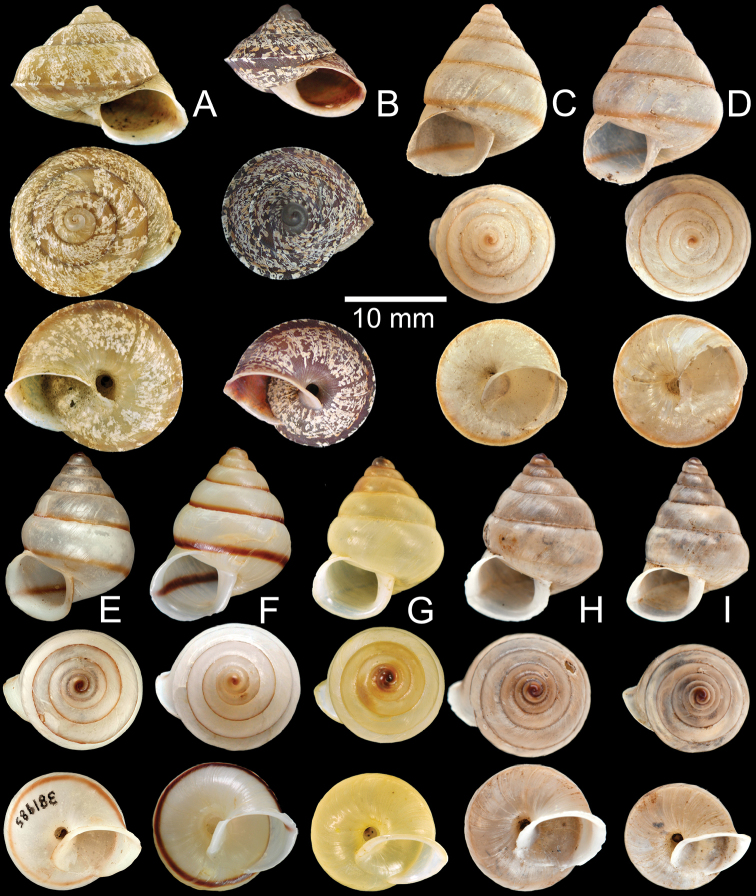
A, BGanesella
carinellaA shell from Lopburi CUMZ 4282 and B shell from Tam Brichinda, Chiangmai CUMZ 4165 C–IGanesella
rhombostomaC lectotype NHMUK 20130215/1 D paralectotype NHMUK 20130215/2-3 E shell of “harryleei Thach, 2017” from Cambodia FMNH 381985 F shell from Klonghad, Srakeo CUMZ 5132 G shell from Chachoengsao CUMZ 5130 H shell from Sirisophon, Cambodia CUMZ 5131 and I shell from Srakaeo CUMZ 4286.